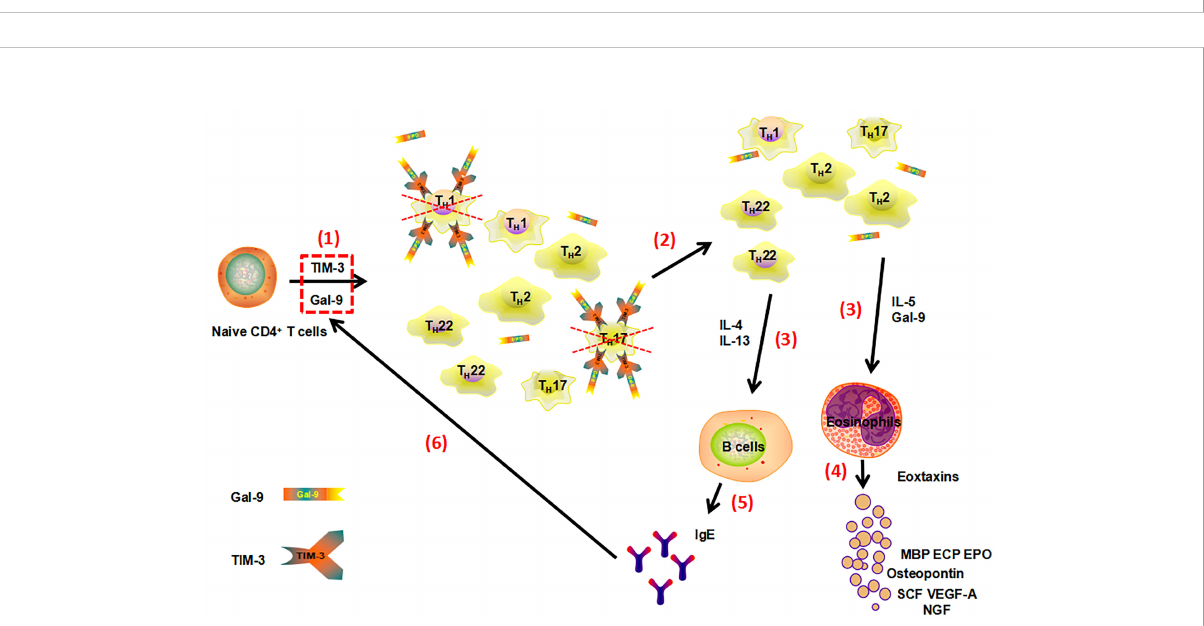
FIGURE 8 Proposed model of the role of Gal-9 and TIM-3 in the pathogenesis of AD. Gal-9, via TIM-3 expressed by T H 1/T H 17 cells, downregulates their numbers, by inhibiting proliferation and the induction of apoptosis (1). The reduction of T H 1/T H 17 immunity leads to T H 2/T H 22 polarization (2). Increased T H 2/T H 22 immunity and cytokines drive type 2 in fl ammation and disease activity (3) with higher numbers of eosinophils(4) and B cell class switching to IgE and elevated IgE levels (5). This, in turn, may drive further upregulation of Gal-9 and TIM-3 expression (6). MBP (Major basic protein), ECP (Eosinophil cationic protein), EPO (Eosinophilperoxidase), SCF (Stem cell factor), VEGF-A (Vascular endothelial growth factor- A), NGF (Nerve growth